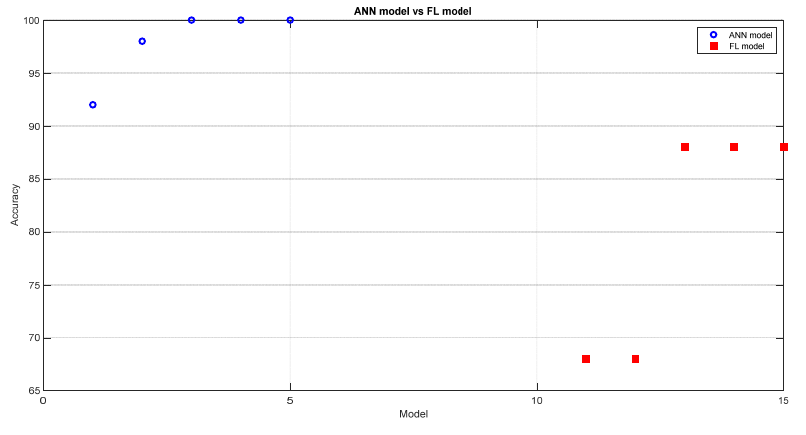
Appl. Sci. 2020 , 10 , x FOR PEER REVIEW Figure 16. Comparison of maturity prediction models. Figure 16. Comparison of maturity prediction models.